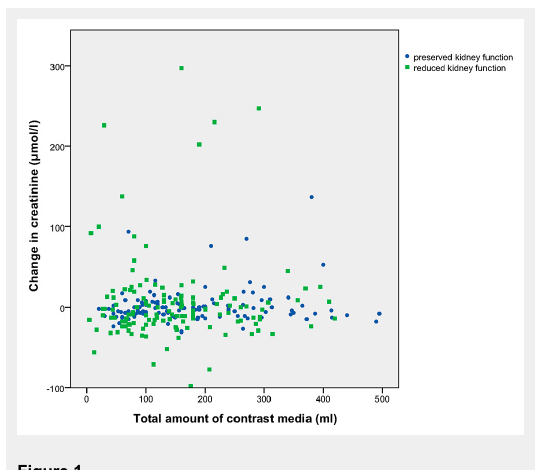
Association between the total amount of contrast media (in ml) administered during and within 5 days prior to TAVI and absolute changes in creatinine (in μmol/l) within 72 hours following TAVI in each patient according to preinterventional kidney function (preserved kidney function: GFR ≥60 ml/min/1.73 m 2 versus reduced kidney function: GFR <60 ml/min/1.73 m 2 ).